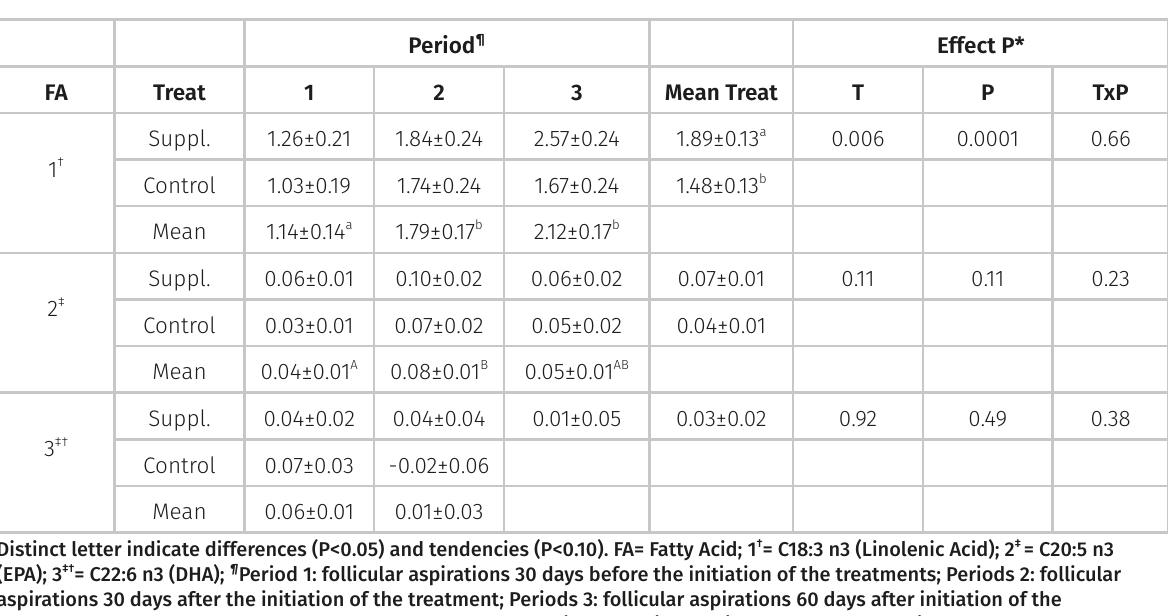
Table III. Effect of linseed-based vegetable oil with addition of salmon oil Canada supplementation on the plasma concentrations of polyunsaturated Omega 6 fatty acid (%) in Mangalarga Marchador mares. Period ¶ Effect P* FA Treat 1 2 3 Mean Treat T TxP Suppl.